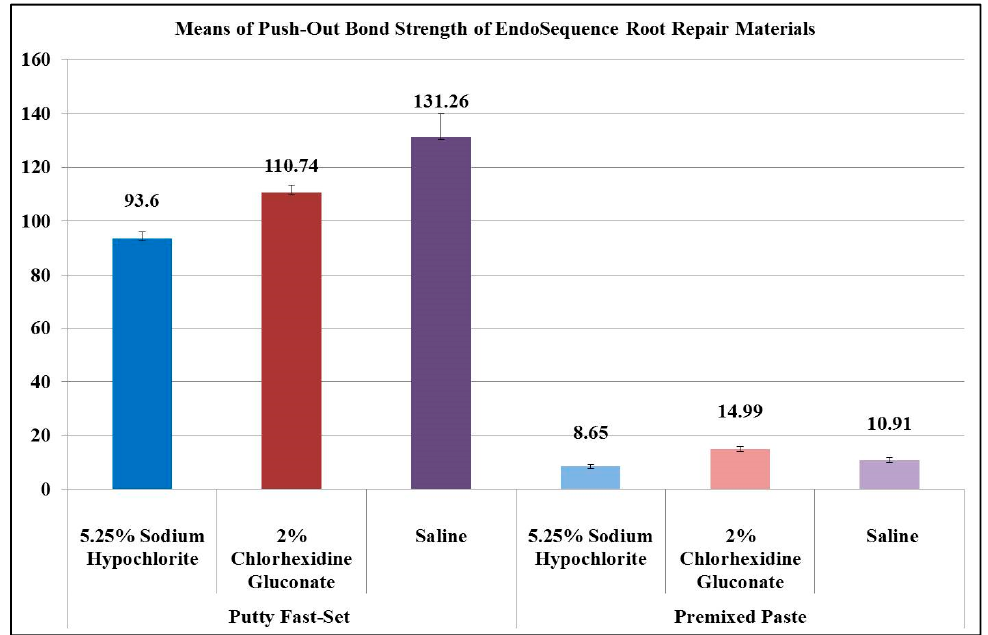
Figure 1. Mean values of experimental groups’ push-out bond strength.